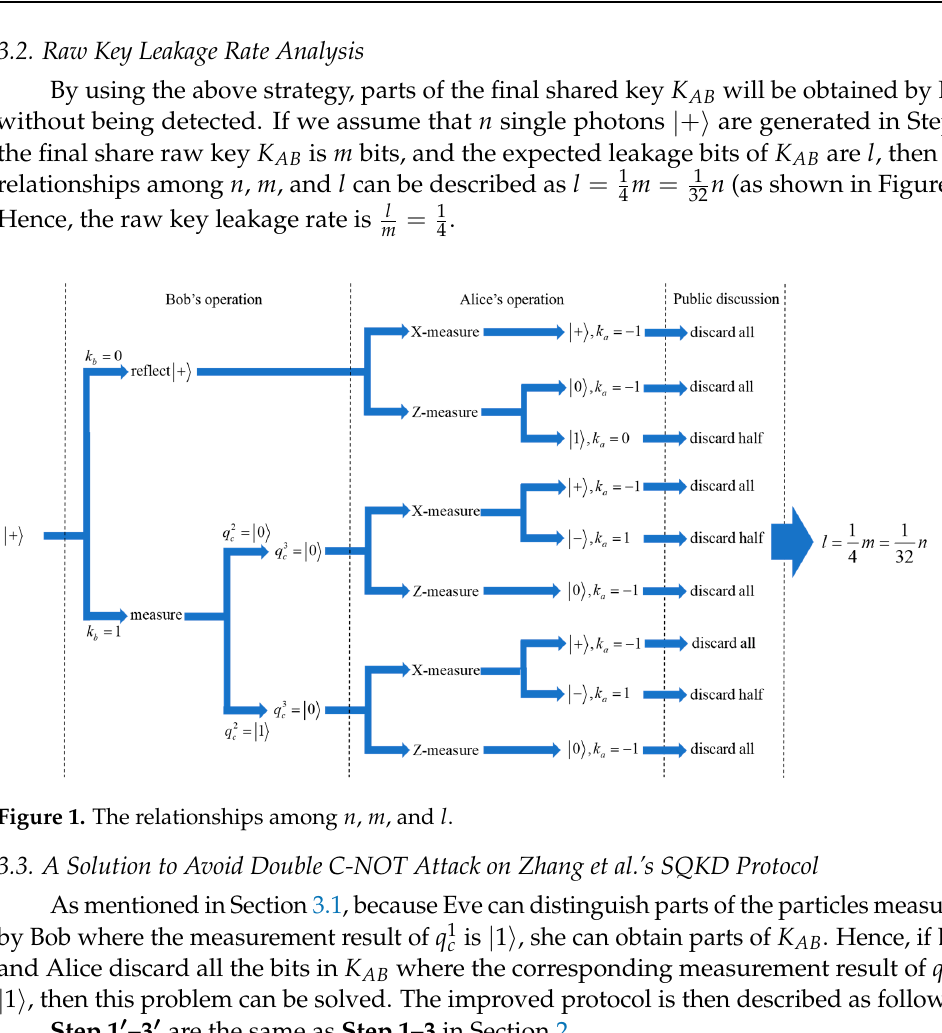
Figure 1. The relationships among